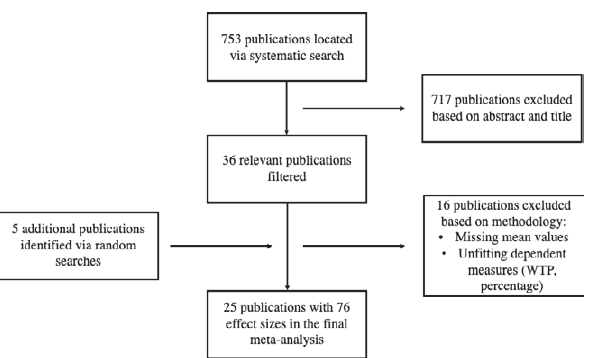
Figure 2. Flowchart of publication gathering and selection process for the